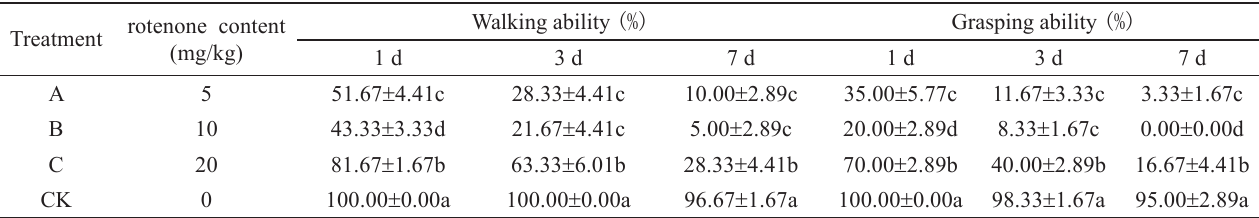
Table 4 . Influences of D. trifoliata roots extract, T. vogelii leaves extract, and rotenone on walking and grasping abilities of micrergates of RIFA (Mean ± SE, %).